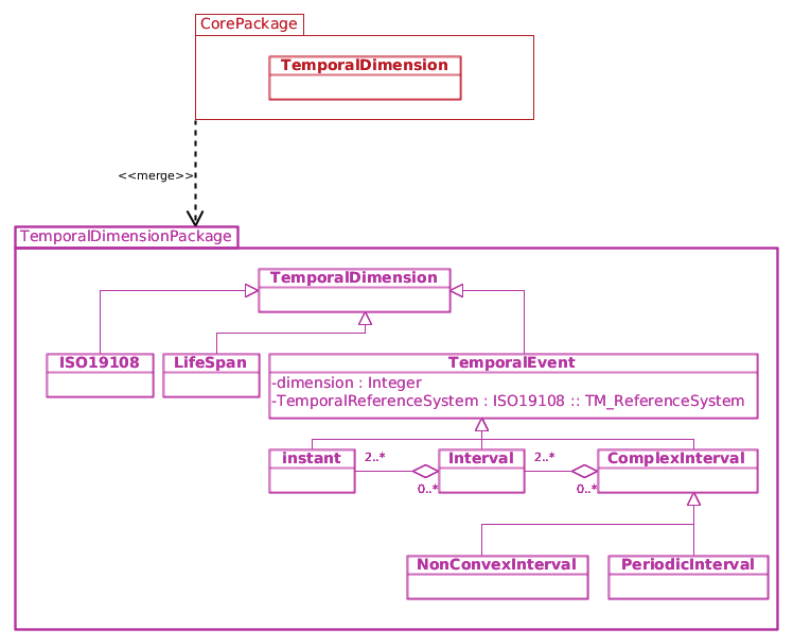
Figure 4: Temporal dimension